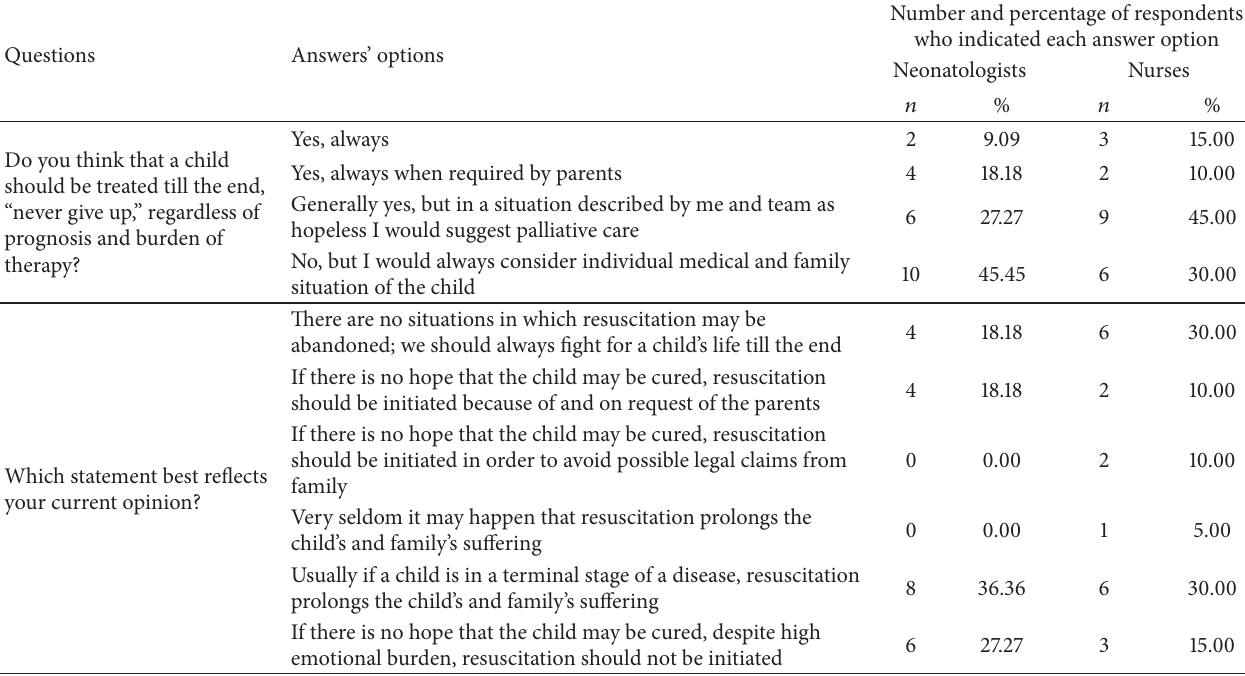
Table 2: Detailed results concerning opinions on withholding